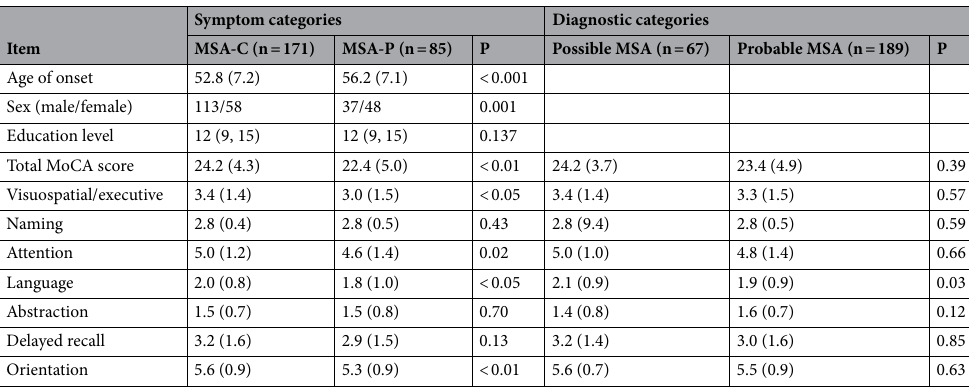
Table 3. Characteristics of cognitive impairment in patients with MSA in different symptom and diagnostic categories. Data are expressed as mean (standard deviation).